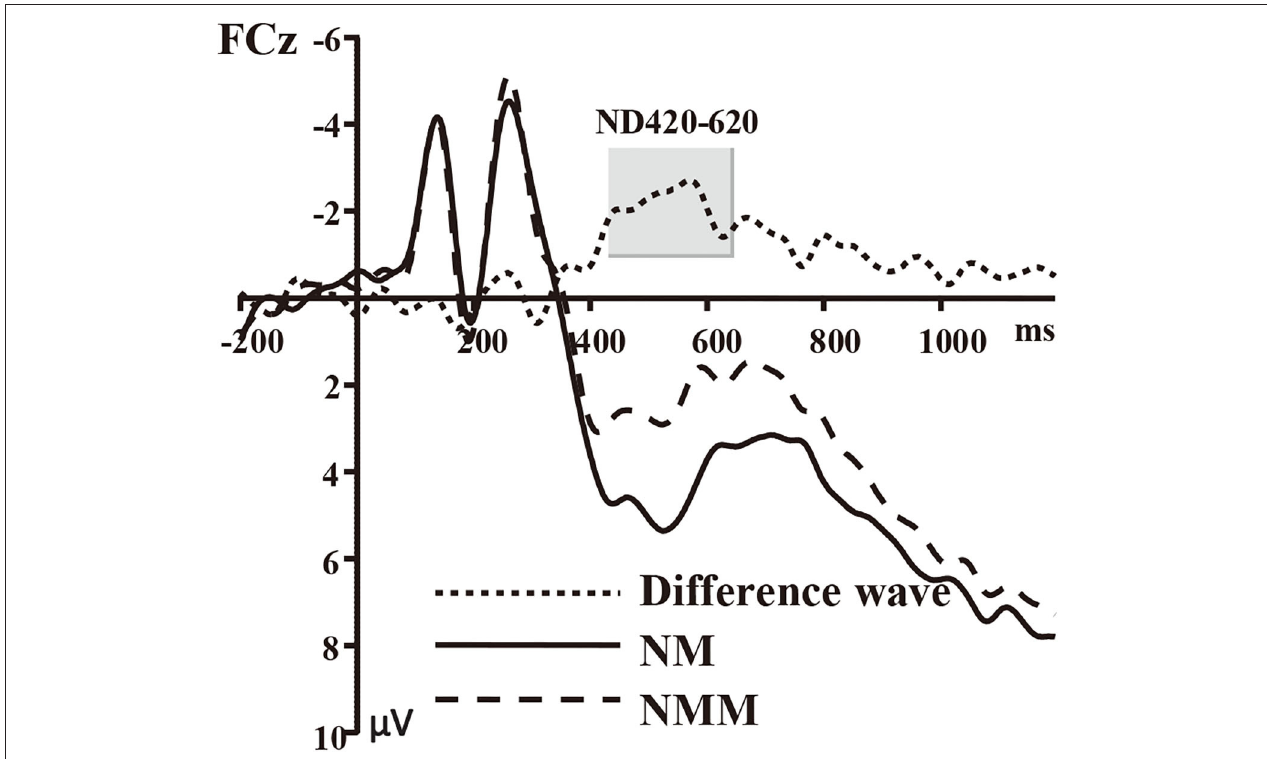
FIGURE 1 | Grand average of event-related potentials recorded in the NMM and NM conditions, along with the NMM minus NM difference wave at